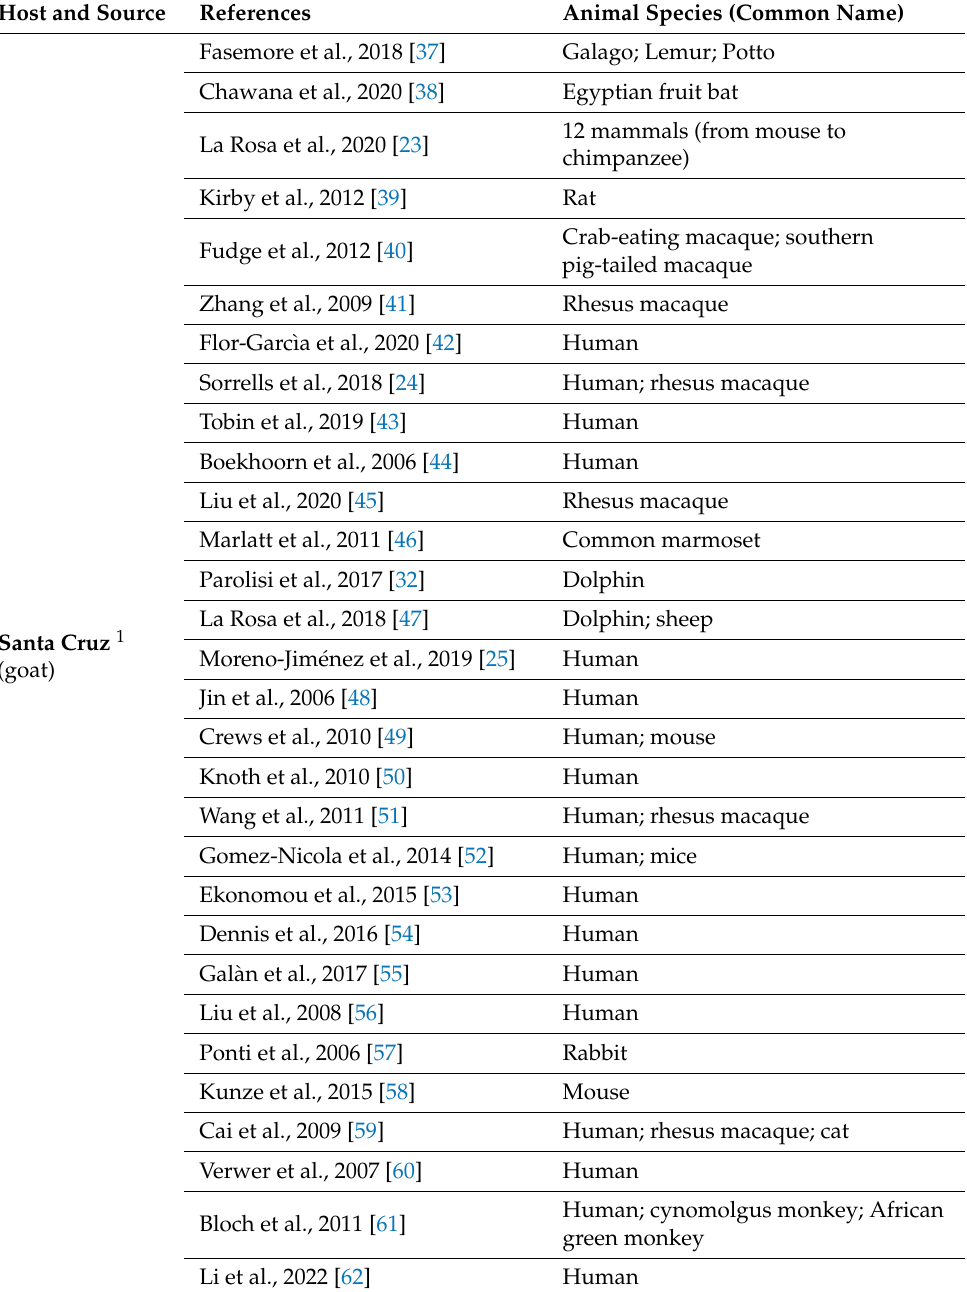
Table 1. Most common antibodies used to detect DCX in different animal